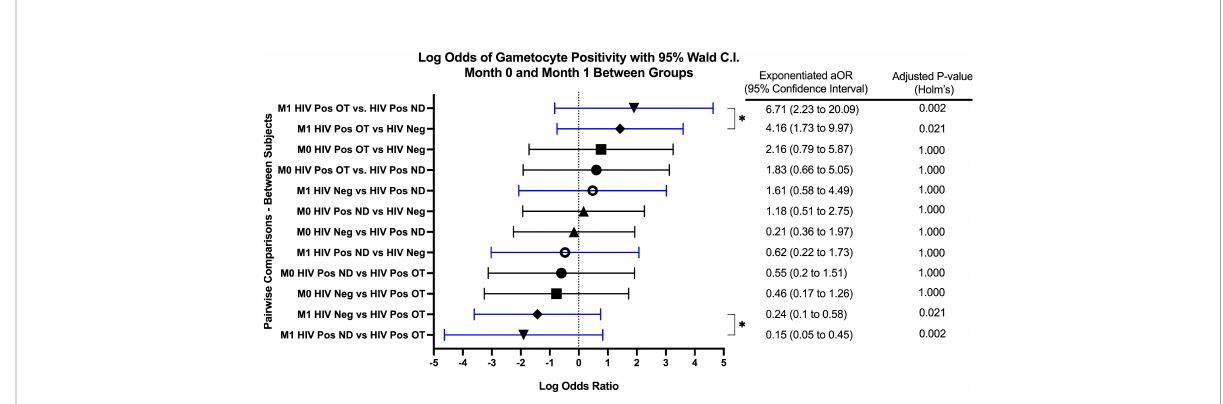
FIGURE 2 Forest Plot of the Log Odds of Gametocyte Positivity in Month 0 and Month 1. The log odds and accompanying exponentiated adjusted odds ratio of being positive for at least one gametocyte speci fi c transcript between each study group in month 0 (M0) and in month 1 (M1). “ HIV Neg ” represents HIV-1 negative volunteers. “ HIV Pos OT ” represents HIV-1 positive volunteers on treatment. “ HIV Pos ND ” represents HIV-1 positive newly diagnosed volunteers. P-values were adjusted using the Holm ’ s method for multiple comparisons. Log odds are arranged in descending order. Blue con fi dence interval lines are comparisons within month 1 and black con fi dence interval lines are comparisons within month